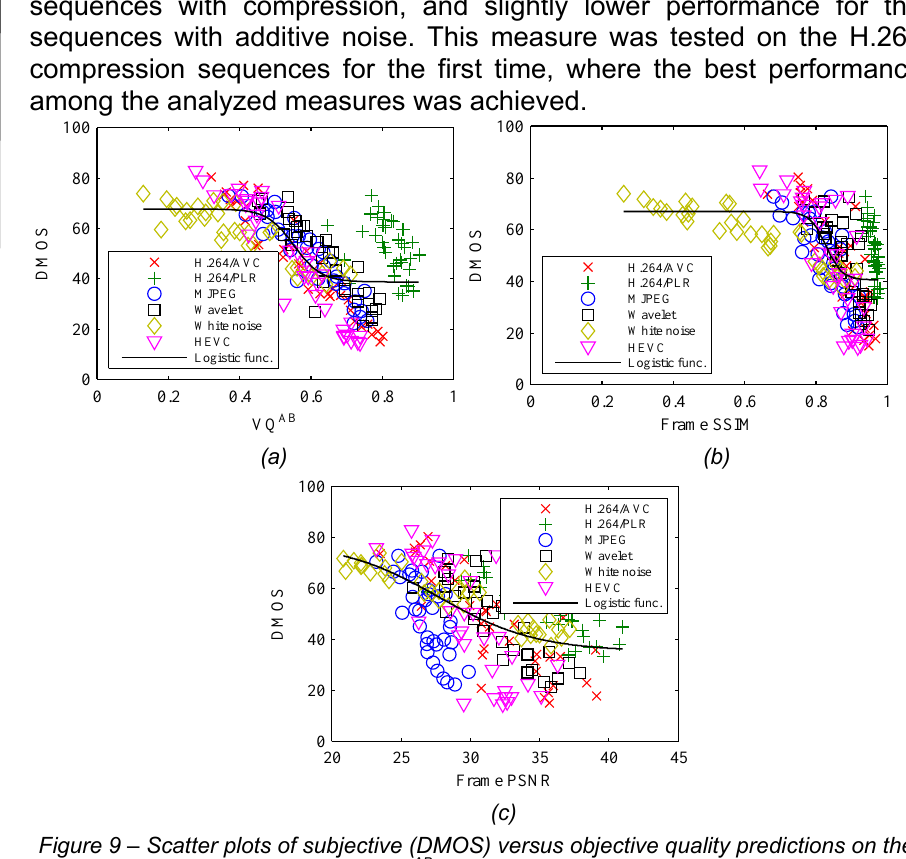
Figure 9 – Scatter plots of subjective (DMOS) versus objective quality predictions on the CSIQ Video Dataset: (a) VQ AB , (b) Frame SSIM and (c) Frame